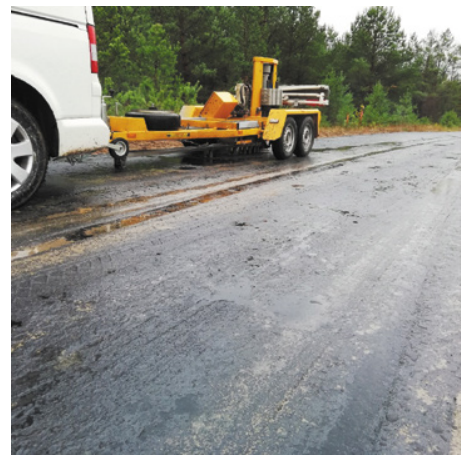
Figure 3. Falling weight deflectometer tests on